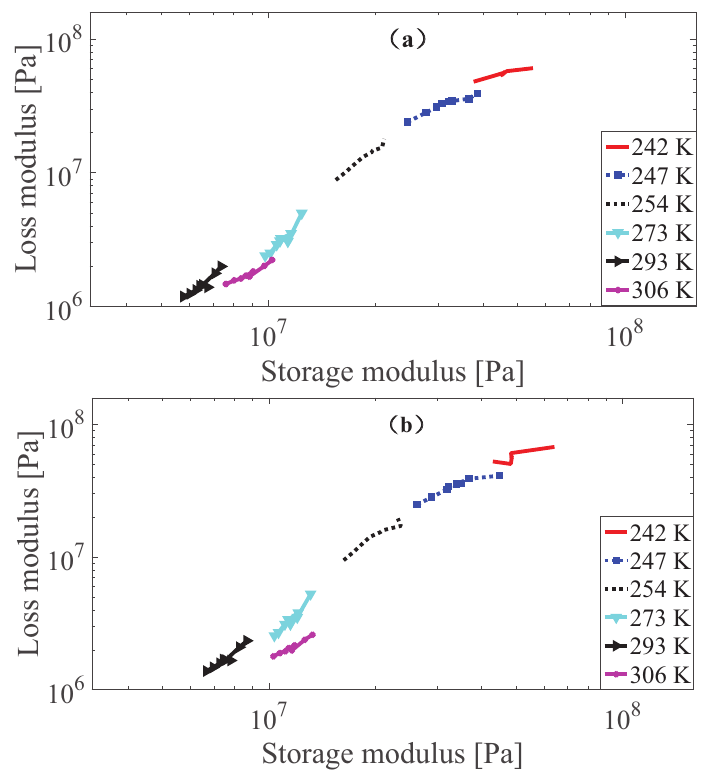
Figure 5. The Cole–Cole plot of dynamic shear modulus at 0.005 strain amplitude with 0T ( a ) and 0.55T ( b ) under different